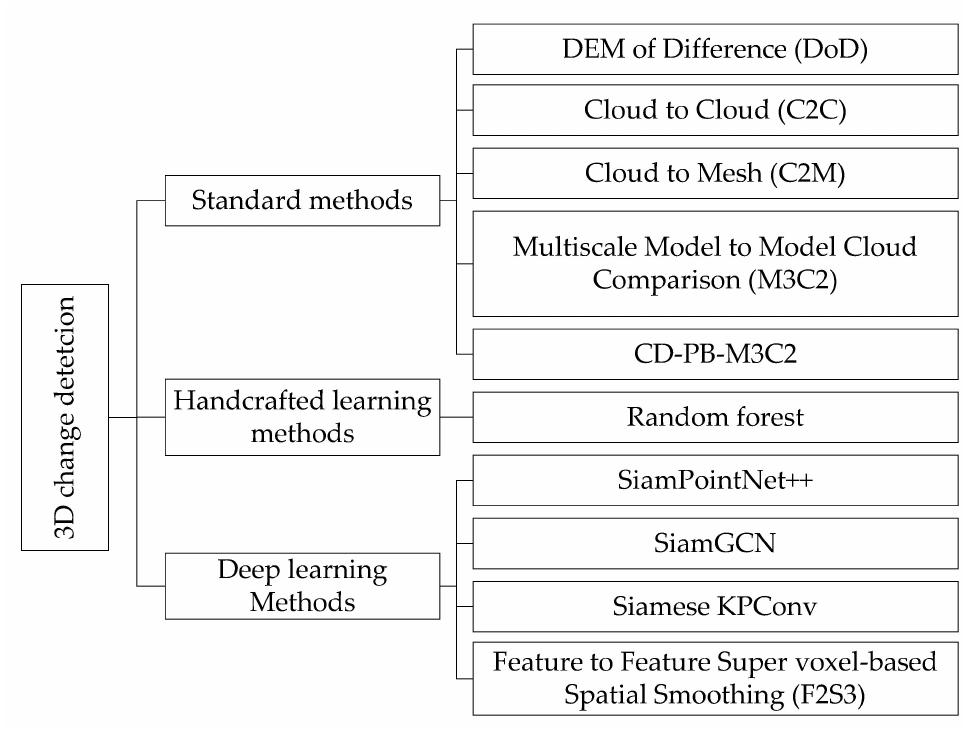
Figure 3. The taxonomy of 3D CD approaches with the methods we will detail in the next